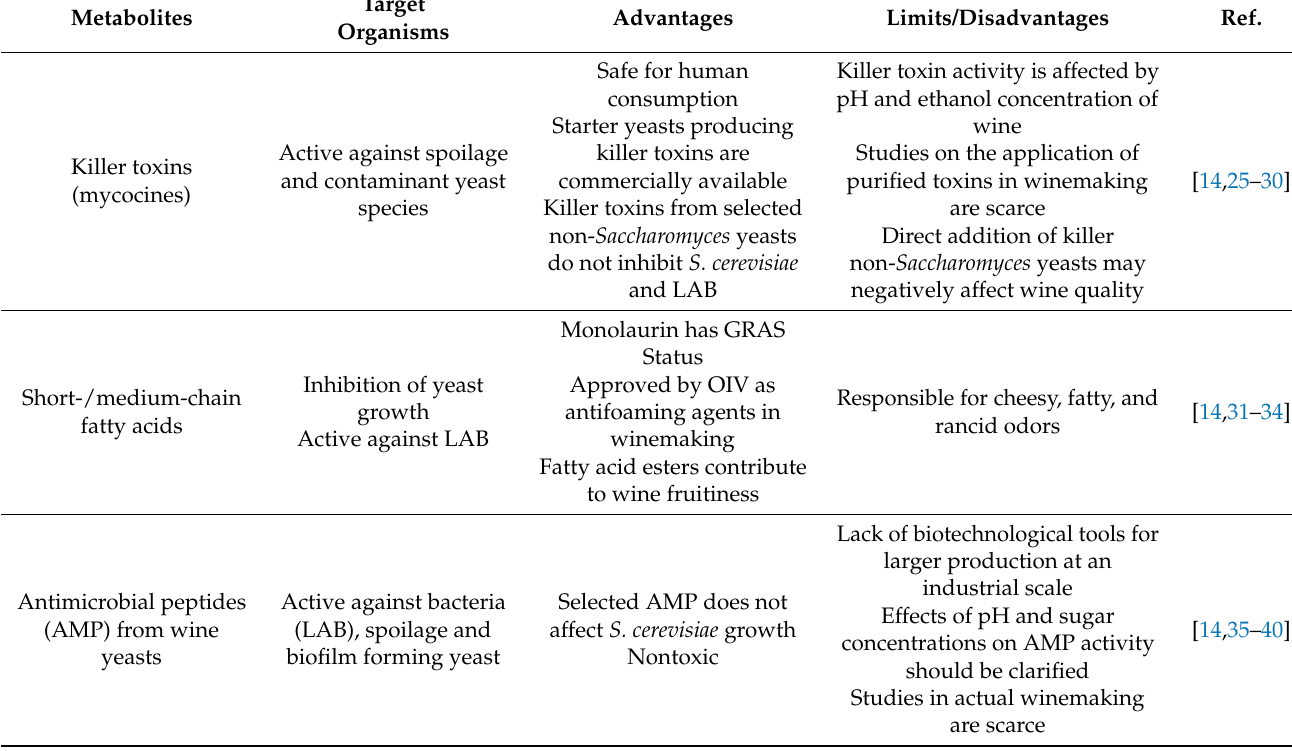
Table 3. Yeast metabolites with antimicrobial activities proposed to replace/reduce SO 2 addition in wine.